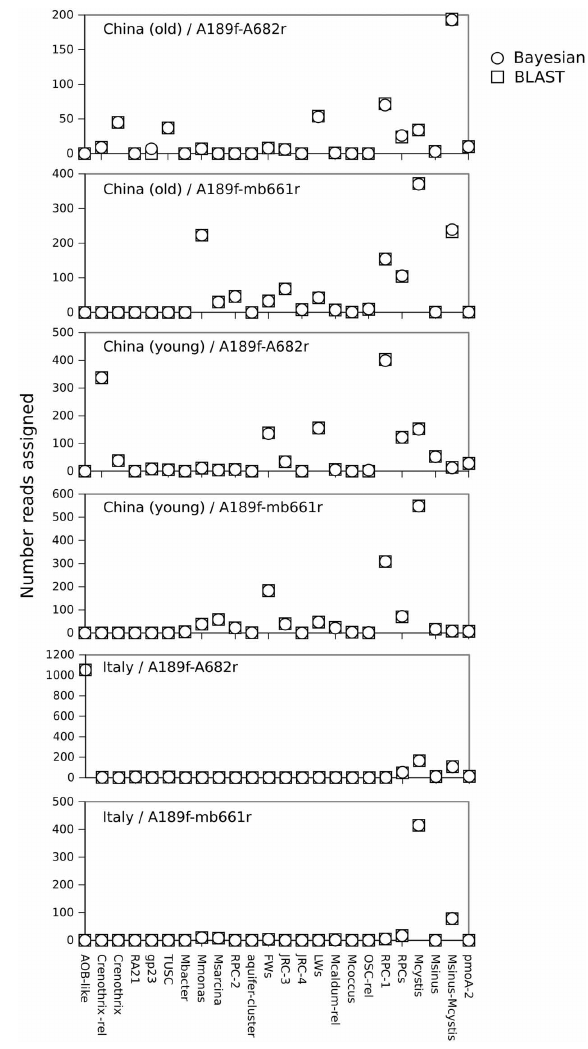
FIGURE 2 | Comparison of classifications of paddy soil pmoA sequence data (Lüke and Frenzel, 2011) using the naïve Bayesian and BLAST/LCA methods. The datasets were generated from three different soils (young Chinese, old Chinese, and Italian) and with two different PCR primer combinations (A189f/A682r, A189f/mb661r) as indicated. The number of sequences assigned to each taxon is plotted. Only pmoA taxa detected in at least one dataset are